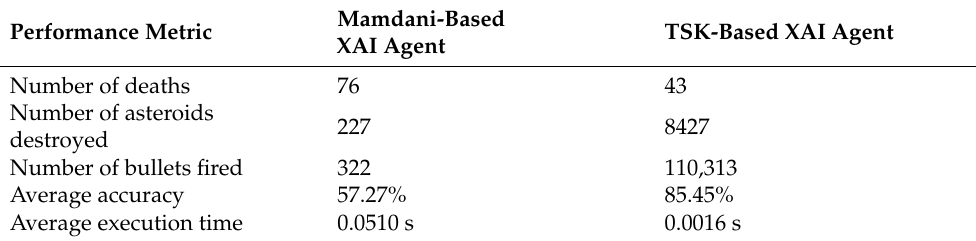
Table 7. Mamdani vs. TSK agent performance. Performance Metric